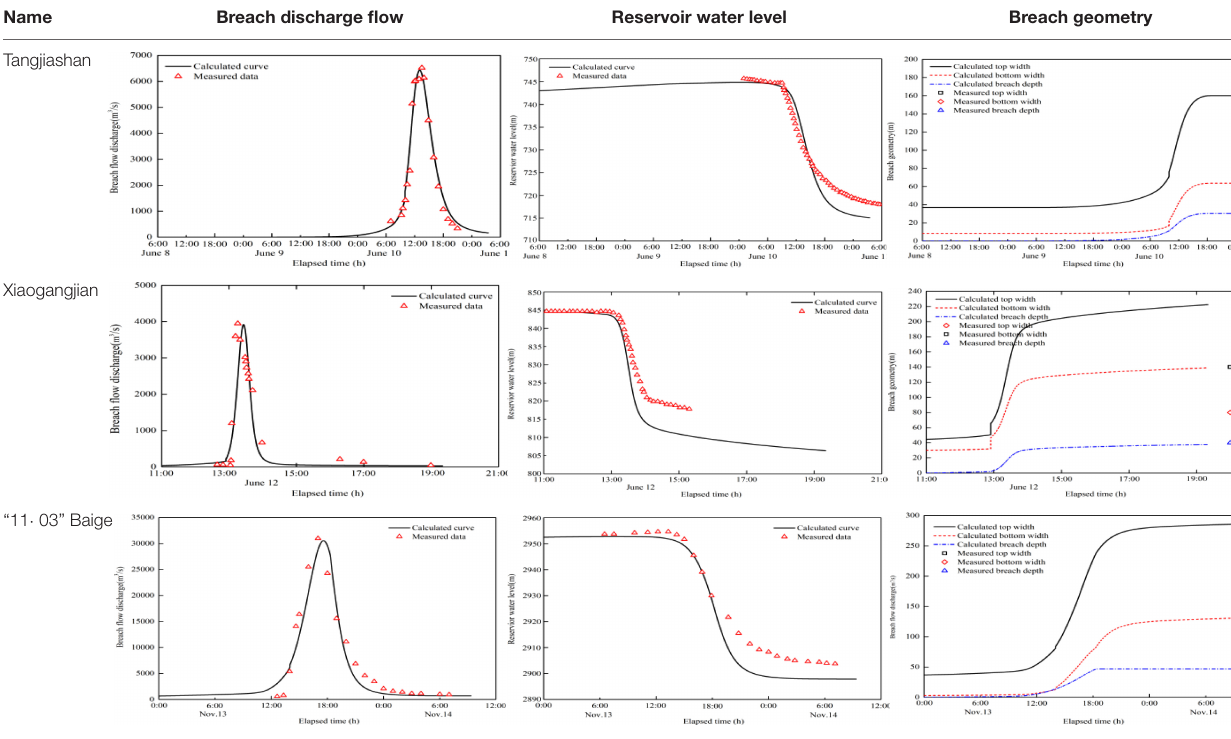
TABLE 6 | Comparison of calculated and measured breach processes.